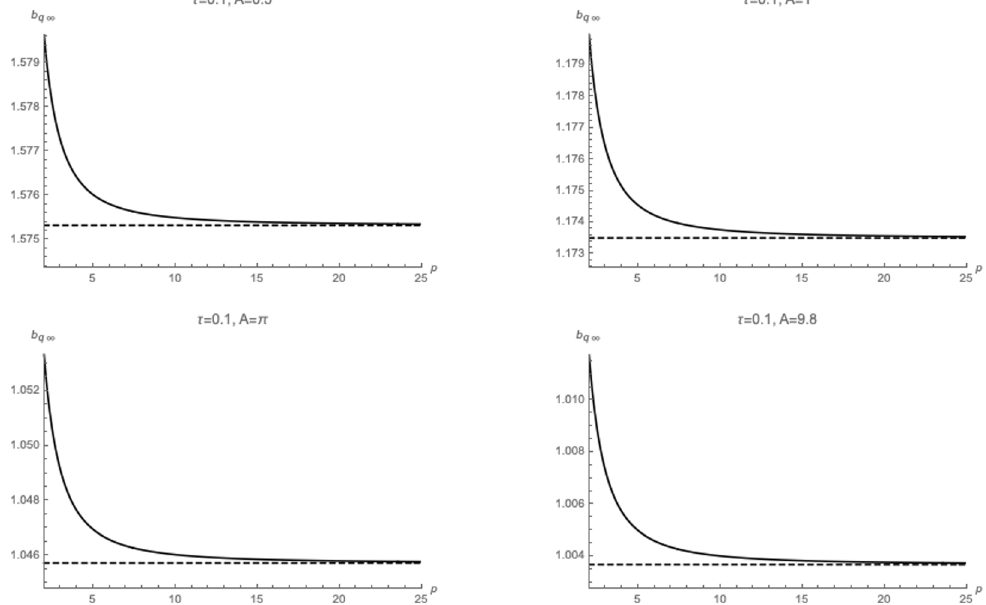
Figure 8 . Plot of b q, ∞ as a function of p at τ = 0 . 1 . The four plots correspond to A = 0 . 3 , 1 , π, 9 . 8 . The dashed horizontal line is the corresponding value of b ∞ in TT -deformed Yang-Mills theory without q